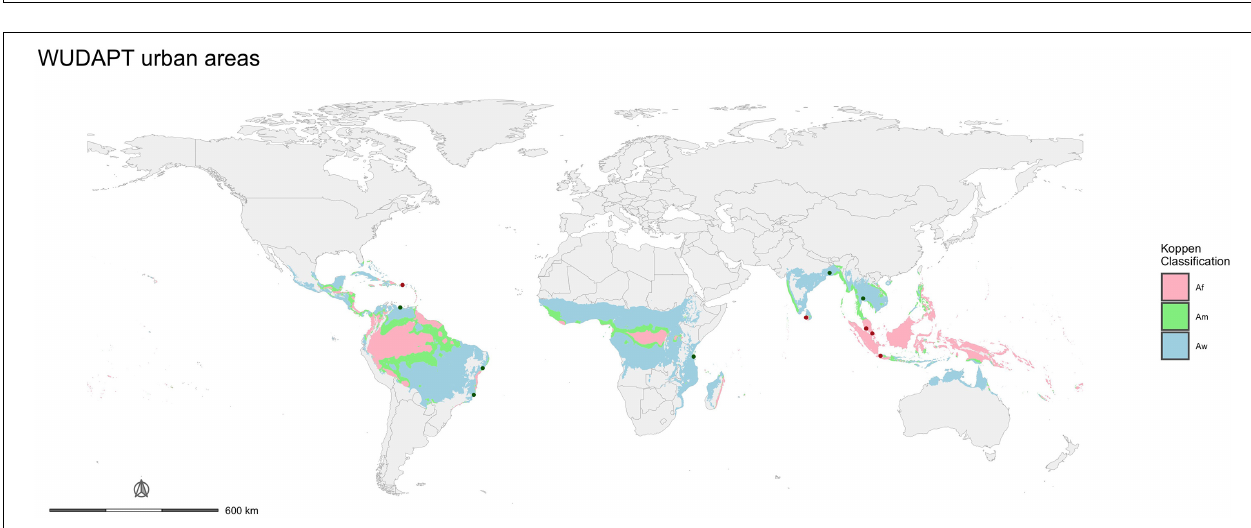
FIGURE 4 | Location of cities with local climate zones data in tropical zones. The dots represent city locations and are color-coded by Köppen-Geiger classification. Data Source: WUDAPT.